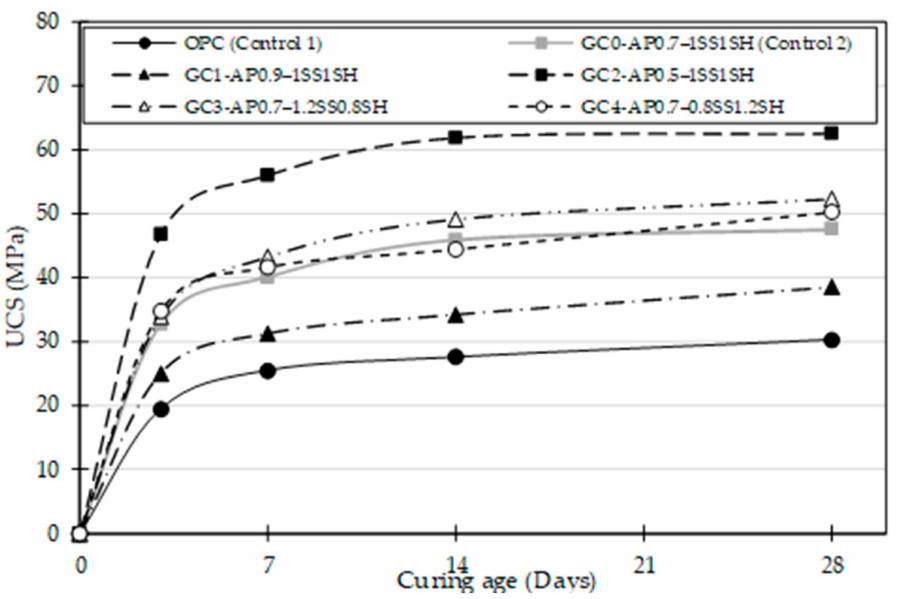
Figure 4. UCS development of the ordinary and geopolymer concrete mixes made with different AP and SS/SH